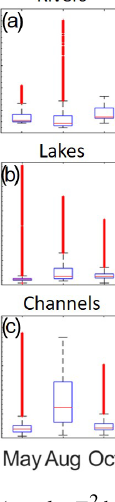
Figure 2. (a, b) Oxygen saturation (%) and CH 4 concentration (µmolL − 1 ) data from the three seasonal campaigns: May, August and October. (c–e) CH 4 concentrations split by water type (rivers, channels and lakes). The blue boxes represent lower (25%) and upper (75%) quartiles, with the whiskers marking the lowest and highest data point within a distance of 1.5 times the interquartile range from the respective quartile. Red “+” signifies points out- side of these boundaries. Median values are shown as horizontal red lines. All data are included ( n > 200000 for each season), including the hot spot and day–night cycle data.